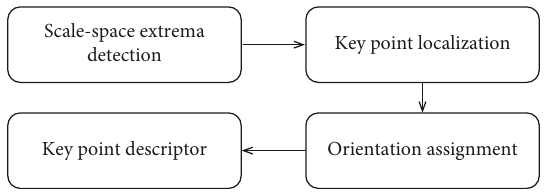
Figure 3: Flow of the feature matching method,